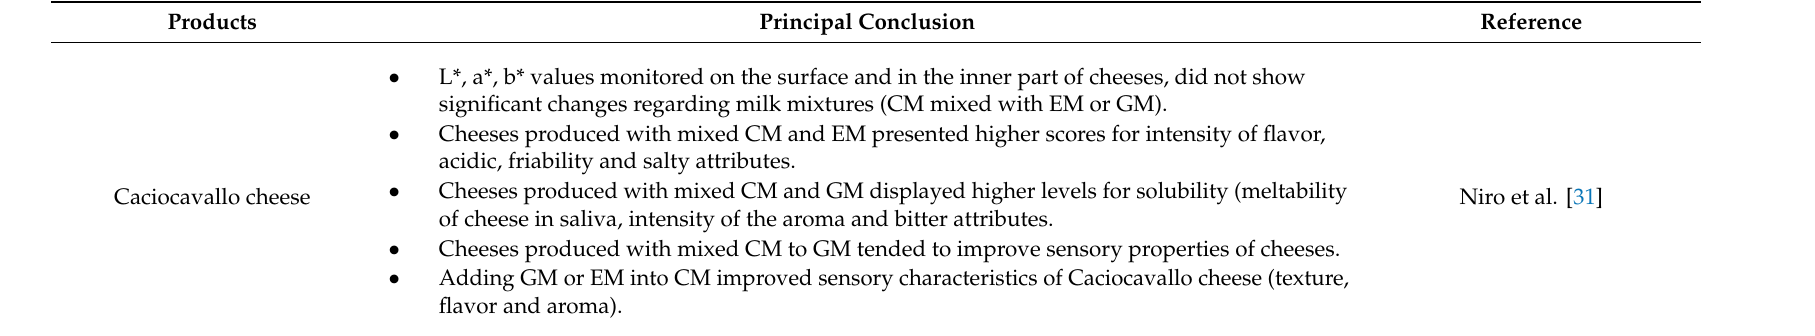
Table 3. Examples of principal conclusions of studies concerning the e ff ect of mixing milk from di ff erent species at di ff erent proportions on rheological and sensory properties of cheeses 1